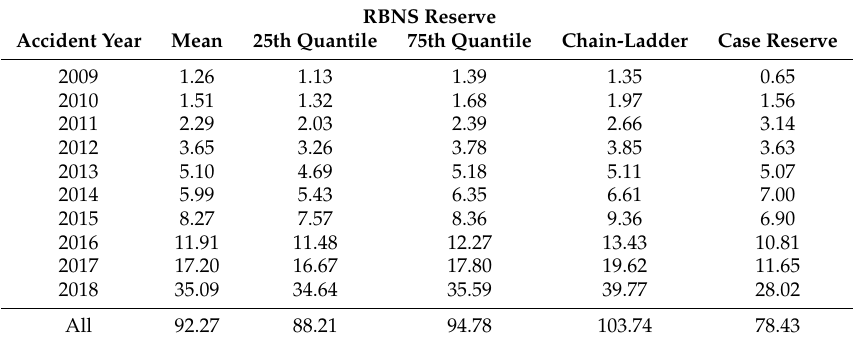
Figure 2. Boxplots of the aggregate ultimate payments from the RBNS claims (in MM). The dots indicate the Chain-Ladder estimates. Table 7. Simulations results and Chain-Ladder (CL) estimates (in